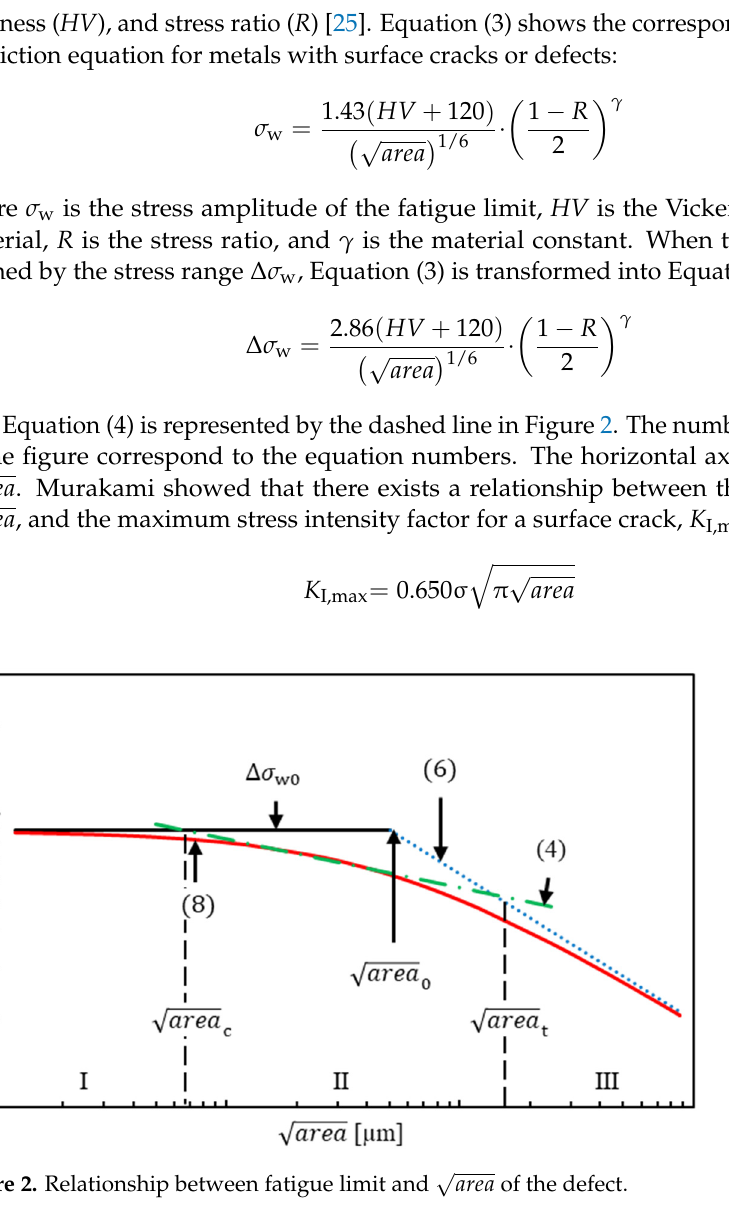
Figure 2. Relationship between fatigue limit and √(cid:1853)(cid:1870)(cid:1857)(cid:1853) of the defect.